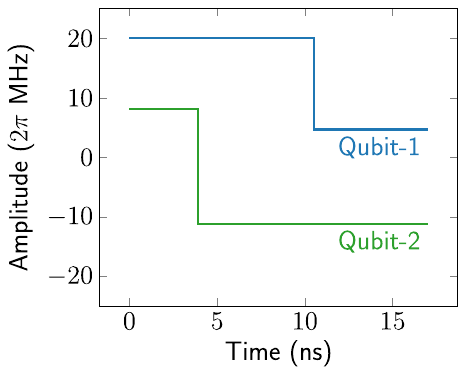
Fig. 10 Illustration of square pulses for a two transmon system. Simple square pulse with two time